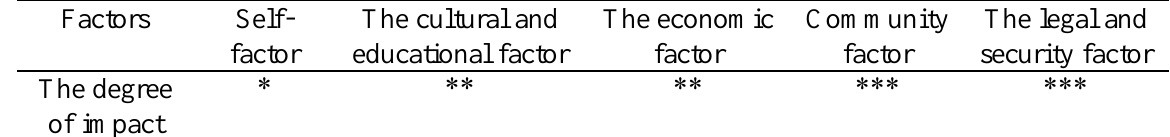
Table 2. The degree of influence of the experiments of the broken windows theory on various factors / Source: The researcher based on the above